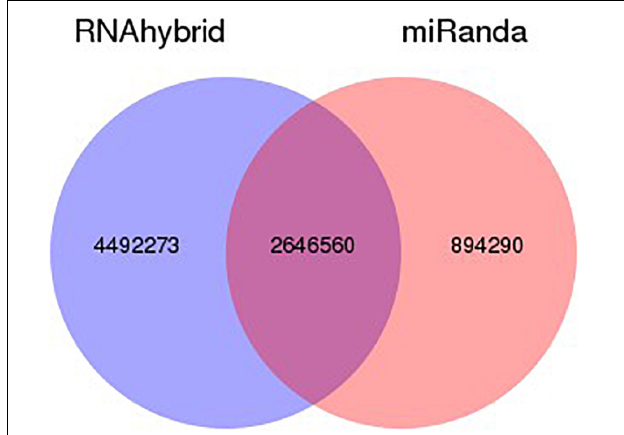
FIGURE 4 | Venn statistics of filtered predicted targets. Using RNAhybrid and miRanda, we identified potential targets for our identified miRNAs. According to the prediction results, among all the predicted targets, most of the targets are shared by both RNAhybrid and miRanda. Comparing such two methods, RNAhybrid may work better with more unique prediction results.